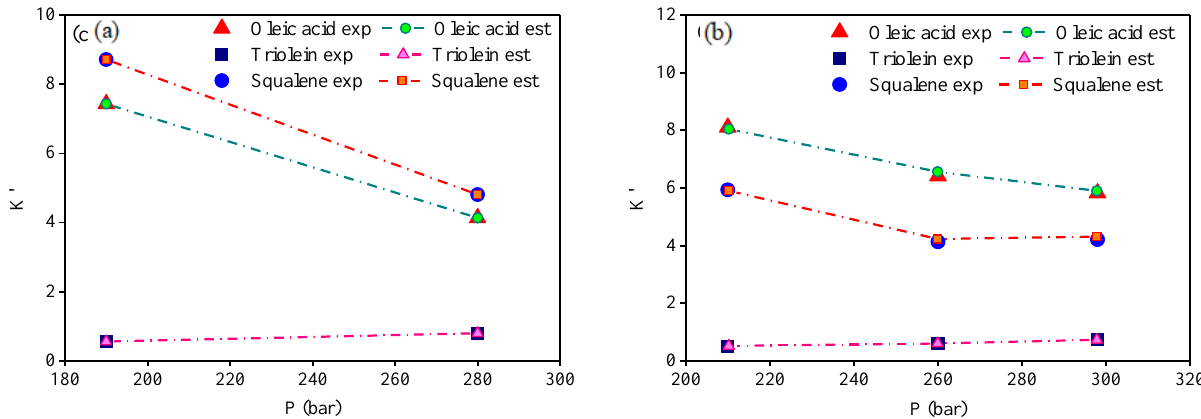
Figure 7. Experimental and estimated distribution coefficients K i , expressed in CO 2 -free basis, at ( a ) 338 and ( b ) 353 K with 5.2 [wt.%] of FFA.